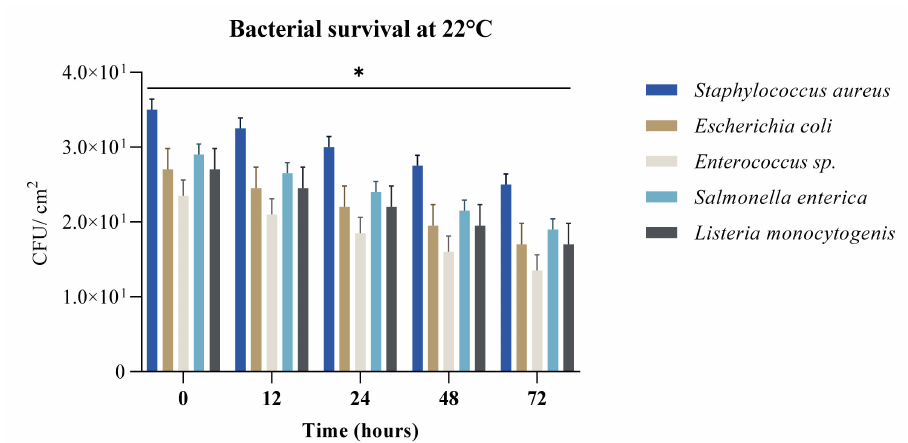
Figure 1. Bacterial survival recorded as CFU/cm 2 at 22 ◦ C, 35% humidity, on various banknotes at five time points (0 h, 12 h, 24 h, 48 h and 72 h) (* p -value = 0.03).